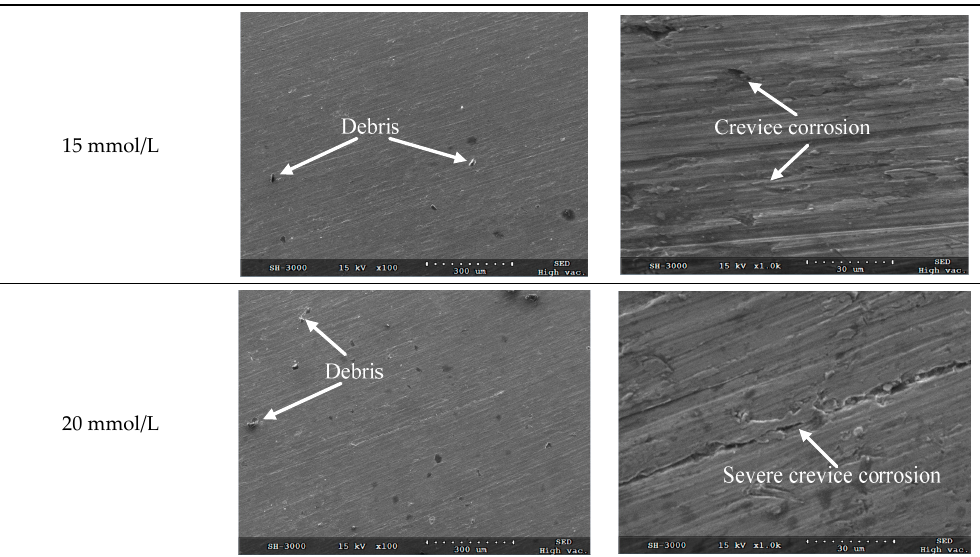
Figure 5. SEM micrographs for the corroded surface of TA2 electrode under different glucose concentrations.